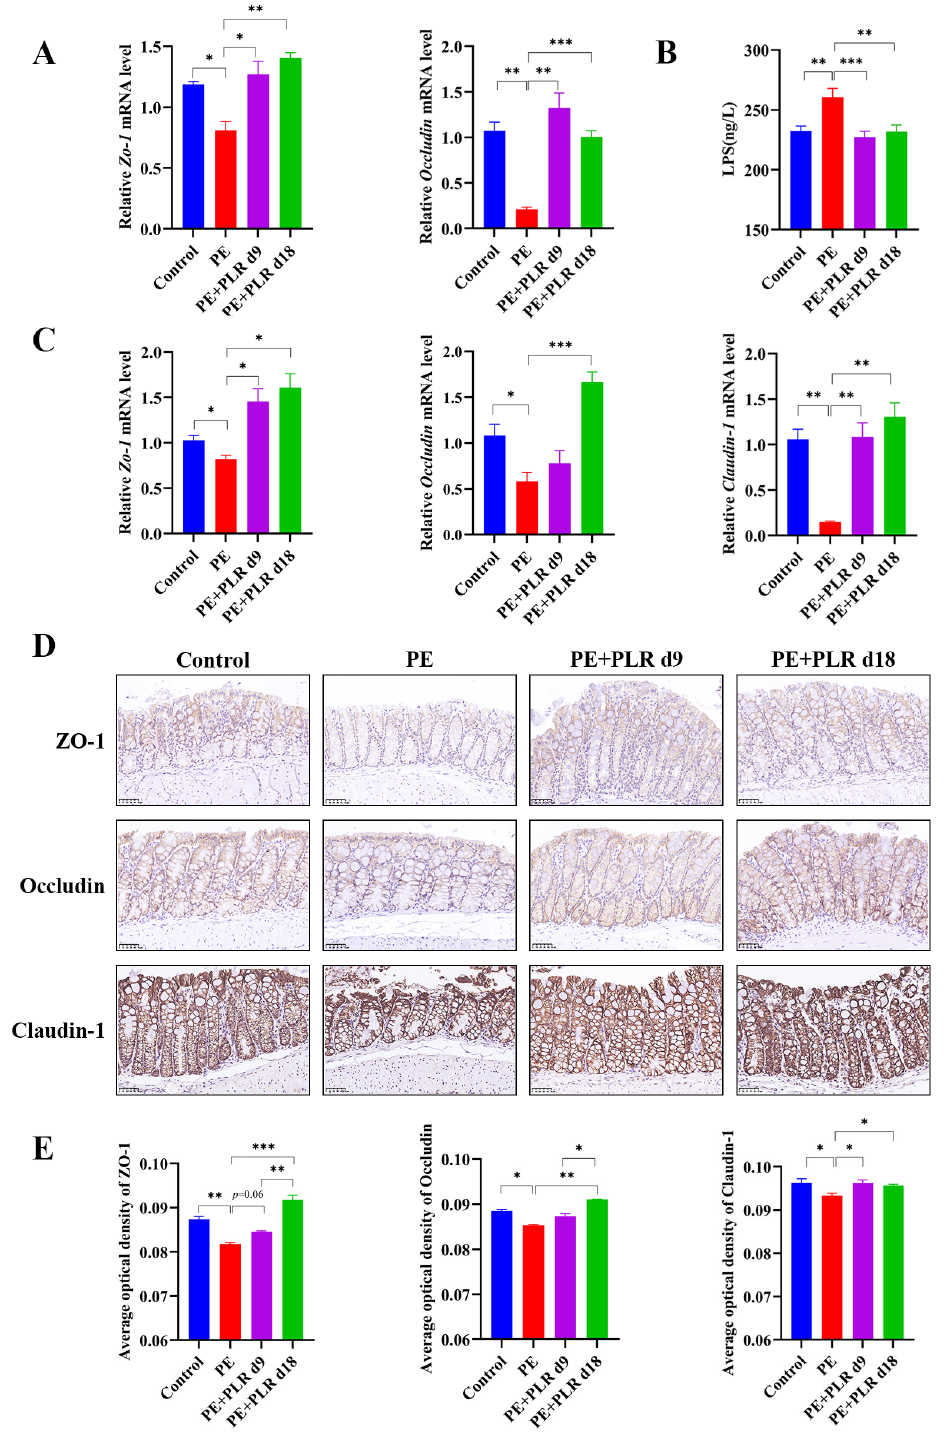
Figure 5. PLR protected the gut and placental barriers in PE mice. ( A ) Relative mRNA levels of Zo-1 and Occludin in placenta. ( B ) Serum lipopolysaccharide (LPS) levels were measured by ELISA. ( C ) Relative mRNA levels of Zo-1 , Occludin , and Claudin-1 in the colon. ( D ) Representative image of ZO-1, Occludin, and Claudin-1 immunohistochemistry staining in colon tissues (original magnification, ×400; scale bar = 50 μ m). The average optical densities of ZO-1, Occludin, and Claudin-1 in the colon ( E ) were measured by Image-Pro Plus software. For ( A , C ), n = 6 for each group. For ( B ), n = 7 for each group. For ( E ), n = 4 for each group. Data are expressed as the mean ± SEM. * p < 0.05, ** p < 0.01, *** p < 0.001 (ANOVA test).